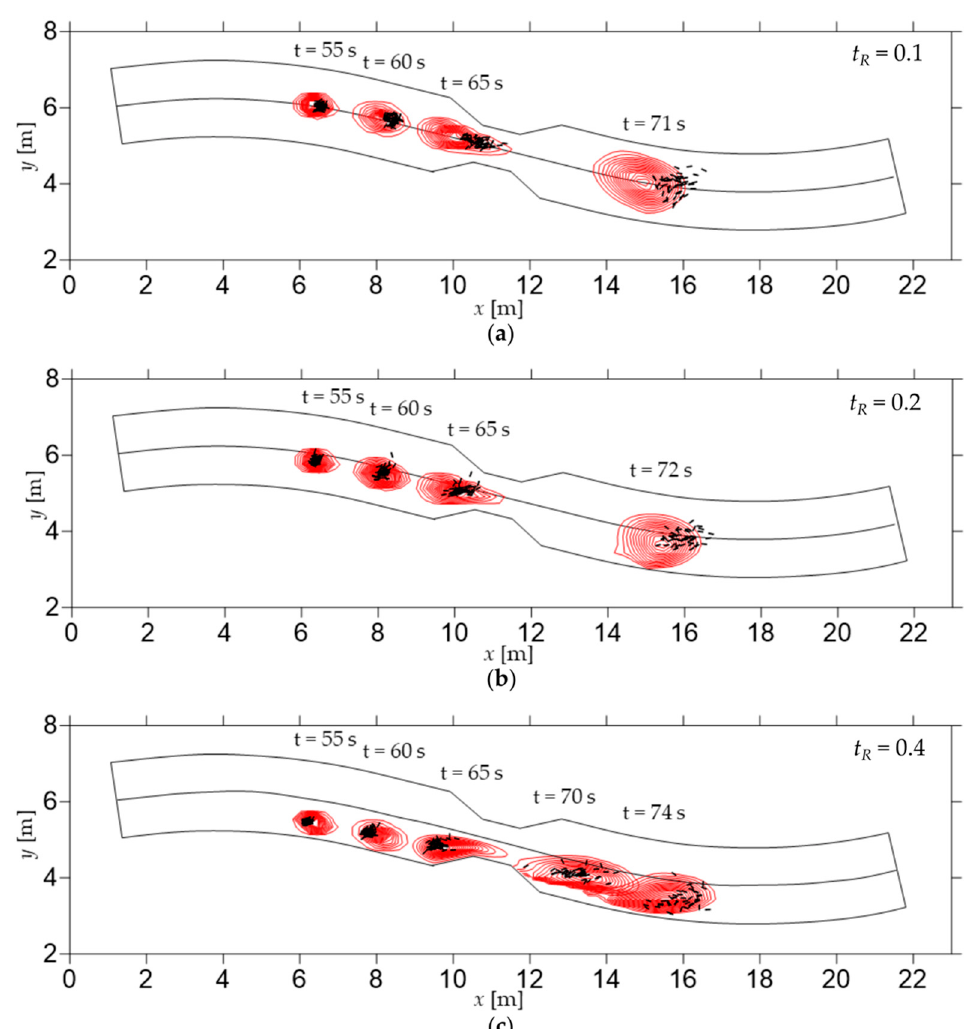
Figure 8. S-shaped flume with narrowing, with experimental wood logs (black segments) and numerical volume averaged concentration (red contours) for different time instants. ( a ) t R = 1 m, L w = 0.3 m, D w = 0.02 m. ( b ) t R = 0.8 m, L w = 0.3 m, D w = 0.02 m. ( c ) t R = 0.4 m, L w = 0.3 m, D w = 0.02 m.